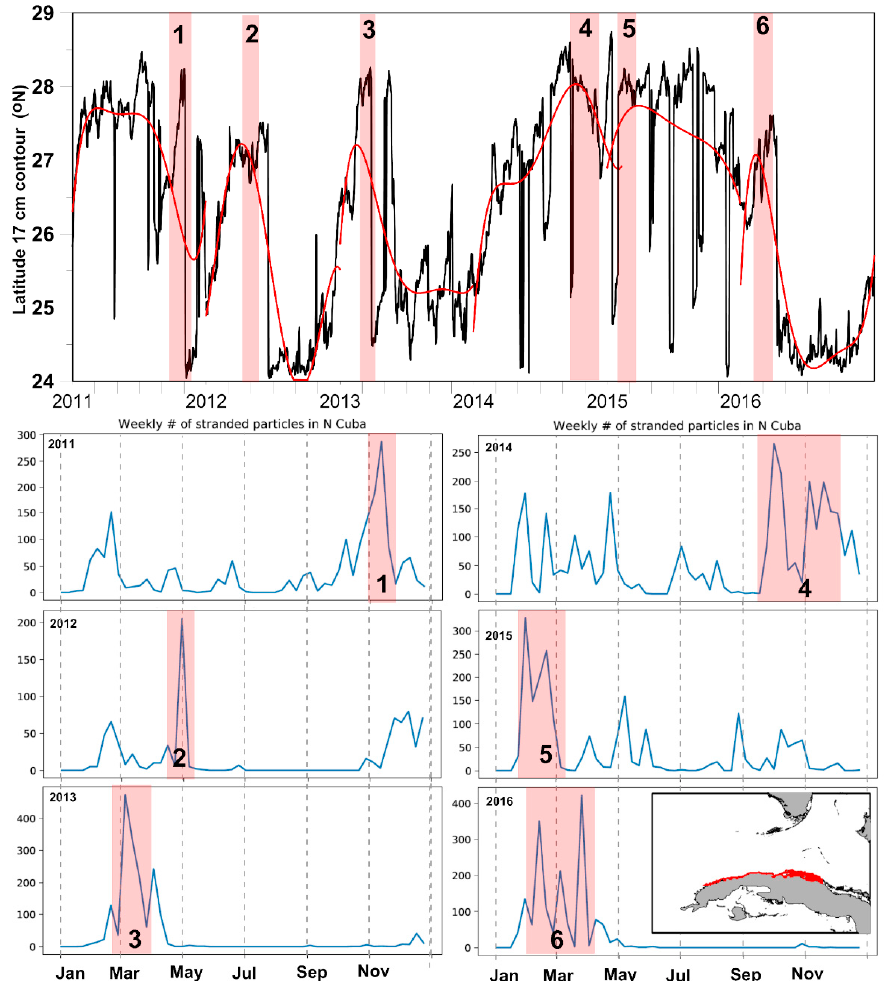
Figure 17. Daily evolution of the maximum latitude (°N) of the Loop Current (LC) defined by the 17 cm Sea Surface Height (SSH) contour (upper panel). The red line indicates the 5th order annual